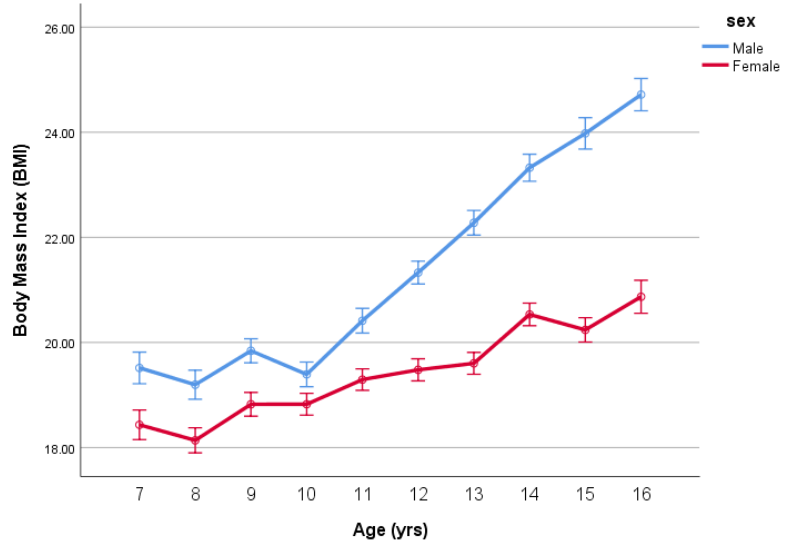
Figure 3. BMI (mean ± SE) by age and sex adjusted for BF%. Table 2. The mean differences in BMI (adjusted for BF%) by age between the boys and girls. Age BMI Male BMI Female